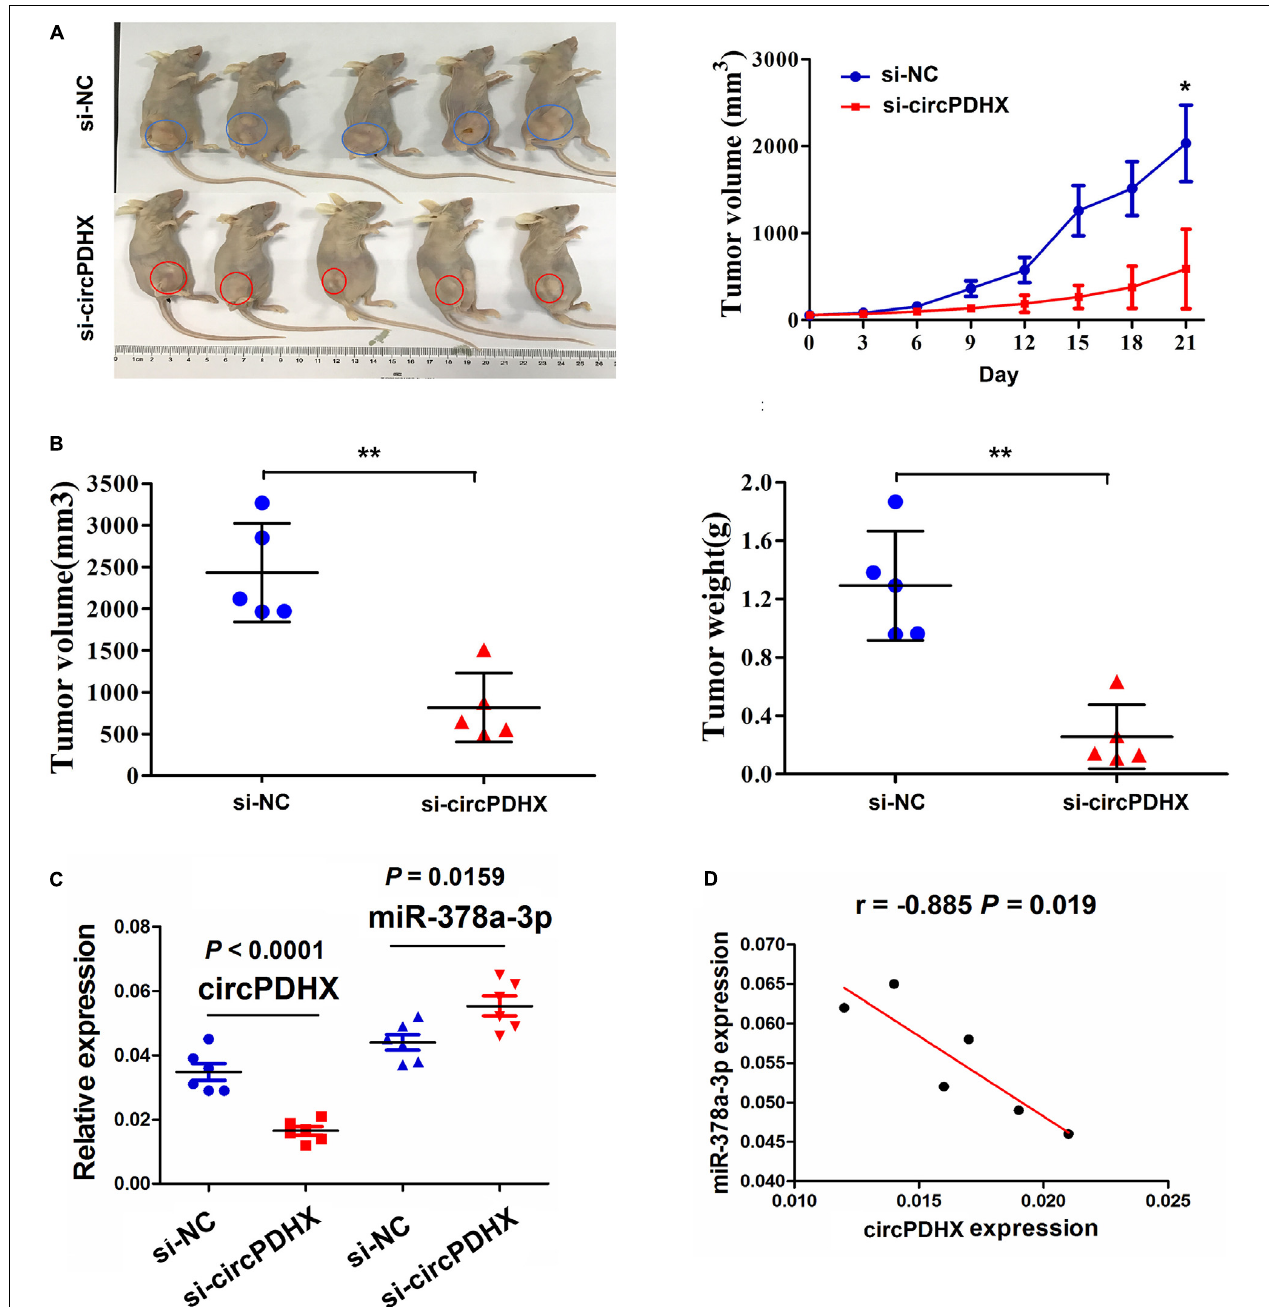
FIGURE 7 | Knockdown of circPDHX suppressed PC3 xenograft tumor growth. (A) Representative photographs of the xenograft tumors and assessment of the tumor proliferation trend after treatment with si-circPDHX or si-NC transfected PC3 cells. (B) Comparison of PC3 xenograft tumor volume and weight between si-circPDHX and si-NC groups. (C) Quantitative real-time PCR (qRT-PCR) analysis of circPDHX and miR-378a-3p expression in si-circPDHX or si-NC treated PC3 tumor tissues. (D) Pearson correlation analysis of the correlation of circPDHX with miR-378a-3p expression in si-circPDHX-treated PC3 tumor tissues. Data shown are the mean ± SEM of three experiments. * P < 0.05; ** P <